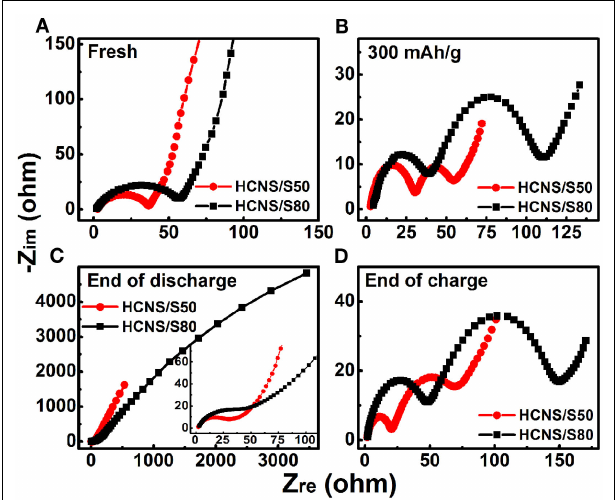
FIGURE 7 | Evolution of impedance spectra of cells with different HCNS/S composite electrodes during initial discharge/charge processes . (A) Before cycling; (B) discharge to a capacity of 300mAhg (cid:0) 1 ; (C) end of discharge (inset is enlarged from high-medium frequency region); (D) end of